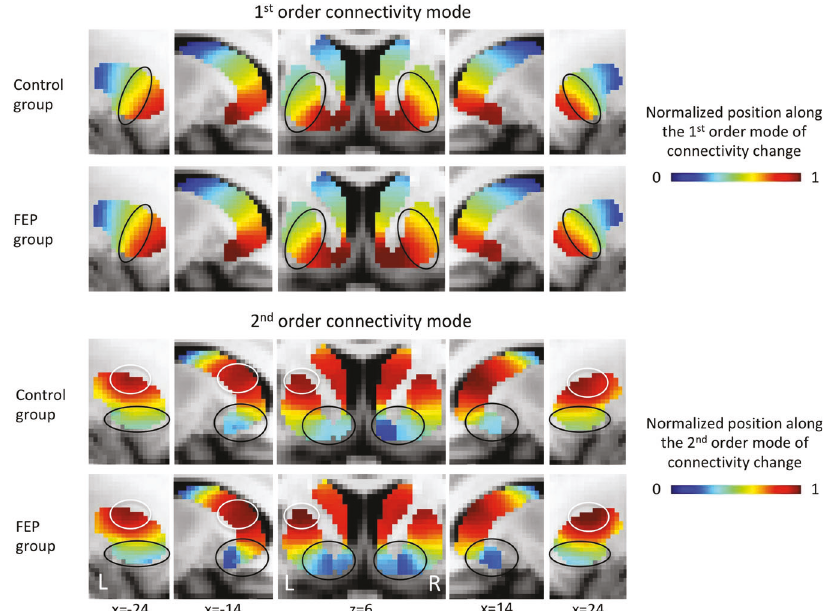
Fig. 2 Disrupted striatal functional connectivity gradients in FEP. Images represent the group-average connectivity modes. Voxels that have similar colors in these connectivity modes have similar connectivity patterns with the rest of the brain, with red and blue colors indicating voxels that are maximally different from each other in terms of their connectivity pattern. Please note that omnibus tests of the TSM coef fi cients summarizing these connectivity modes revealed that the FEP and control group were signi fi cantly different, and that these fi gures have purely been added for visualization purposes. For the fi rst-order connectivity mode, we can see that group differences are mainly evident in the mid-section of the gradient in the putamen region of striatum (circled). For the second-order connectivity mode, differences are evident in both the dorsal (circled in white) and ventral regions (circled in black) of striatum. L left, R